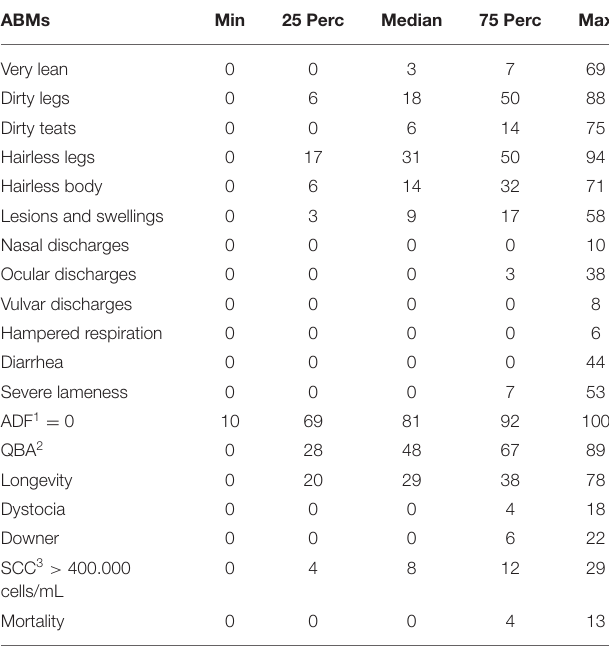
TABLE 1 | Characteristics of dairy farms involved ( n = 69). Explanatory variable